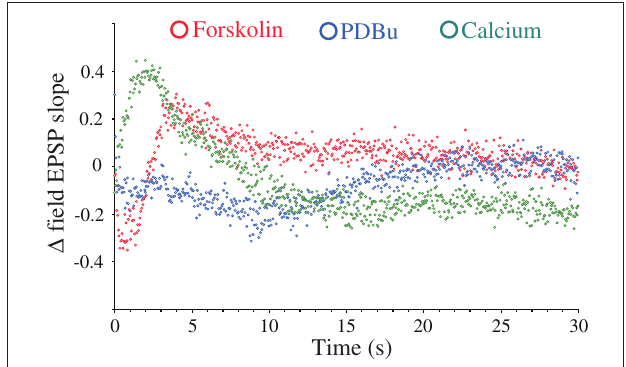
. Subtraction 2 (green symbols) and 2